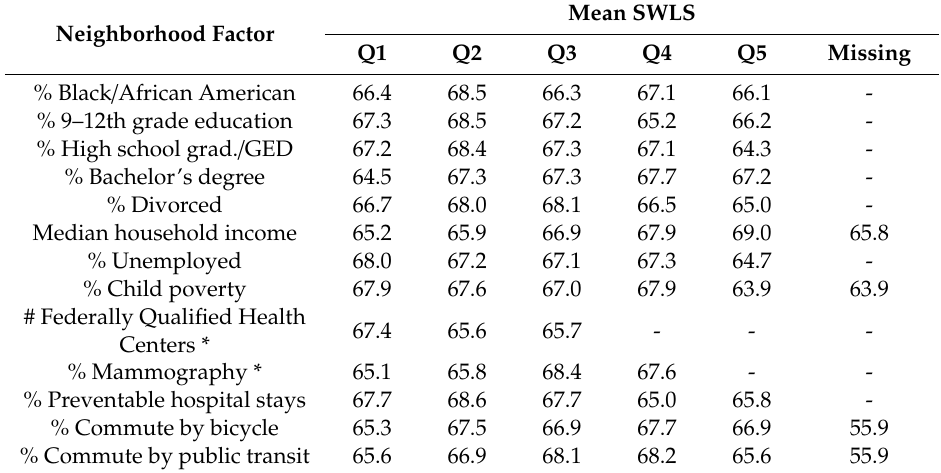
Table 3. Average SWLS Score for Stanford Well for Life Participants by Neighborhood Factor Quantile (lowest = Q1 to highest = Q5).